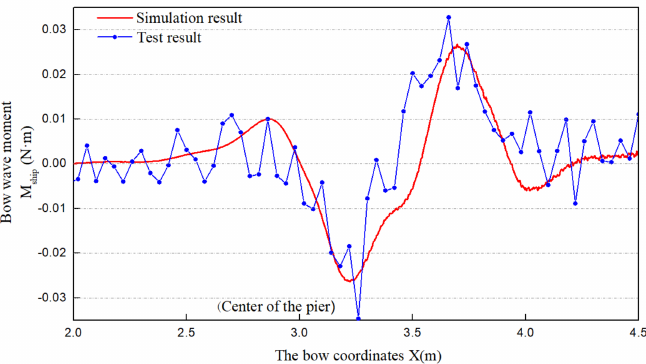
Figure 22. Change law of the bow roll